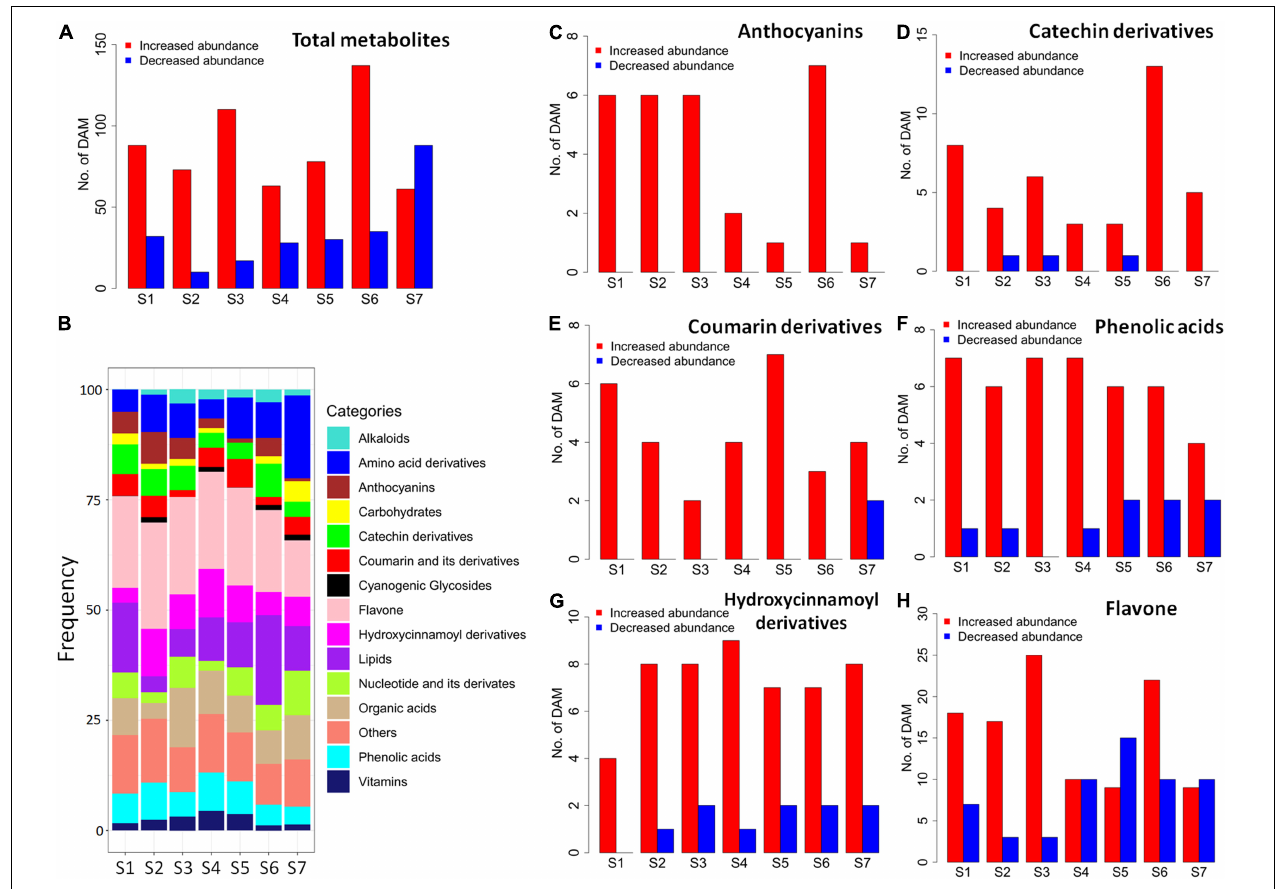
FIGURE 2 | Differentially accumulated metabolites between SC9 and SC205 during tuberous root development. (A) Number of all abundance-increased and abundance-decreased DAMs, which showed higher and lower metabolite levels in SC9 than SC205, respectively. (B) Category frequency of all DAMs. (C–H) Number of abundance-increased and abundance-decreased DAMs relevant to anthocyanins, catechin derivatives, coumarin derivatives, phenolic acids, hydroxycinnamoyl derivatives, and flavones,